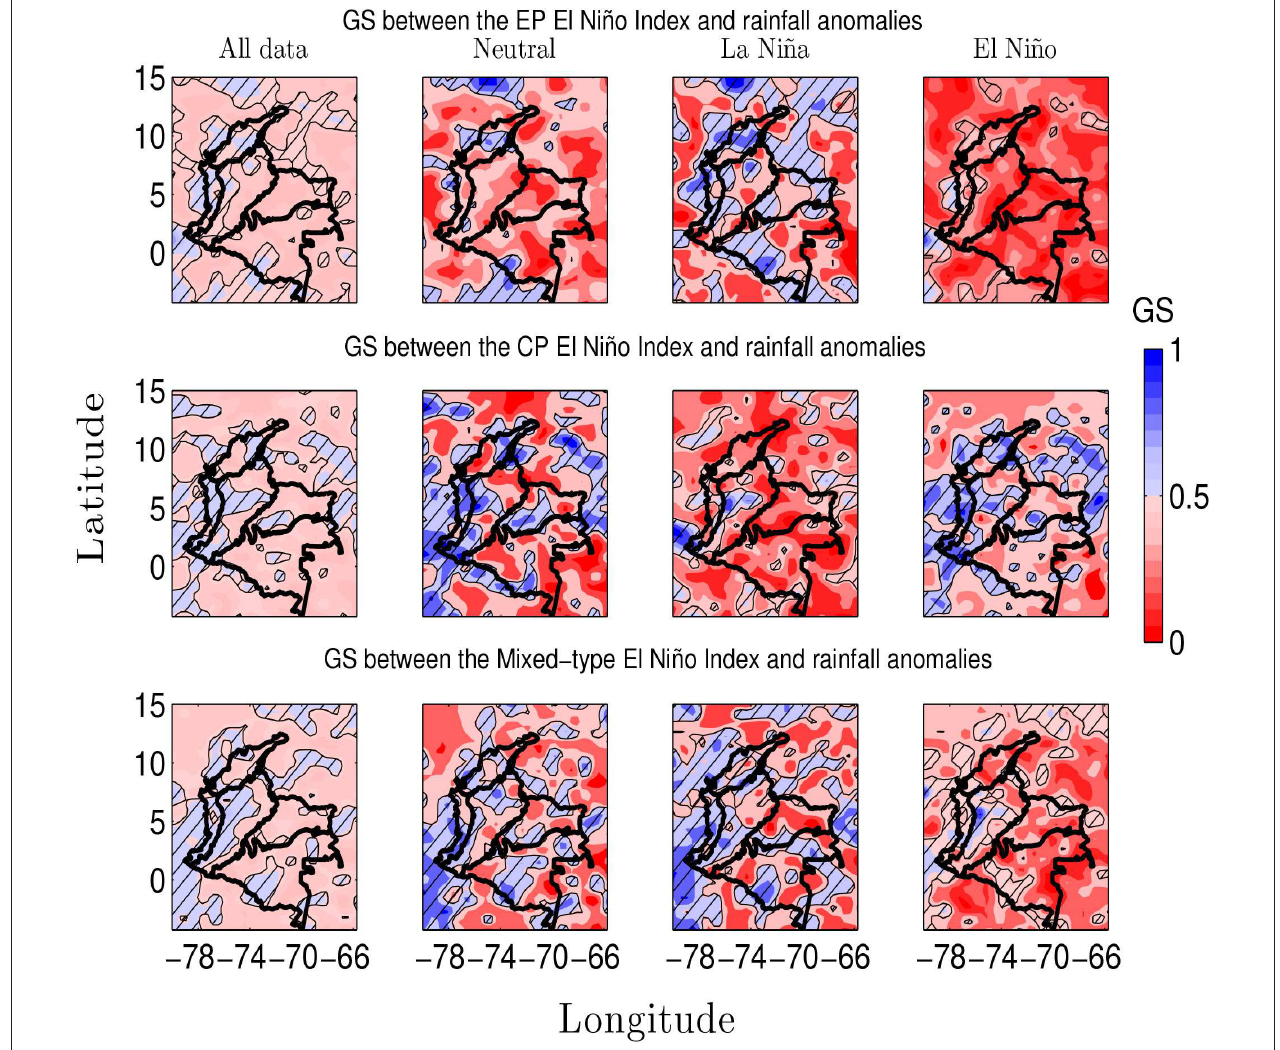
FIGURE 14 | Generalized synchronization between indices for different types of ENSO and rainfall anomalies throughout Colombia. (Top row) Eastern Pacific (EP) El Niño type. (Middle row) Central Pacific (CP) El Niño type. (Bottom row) Mixed-type El Niño. Dataset No. 1, period 1975–2006. The hatched contours indicates zones where the GS is significant at